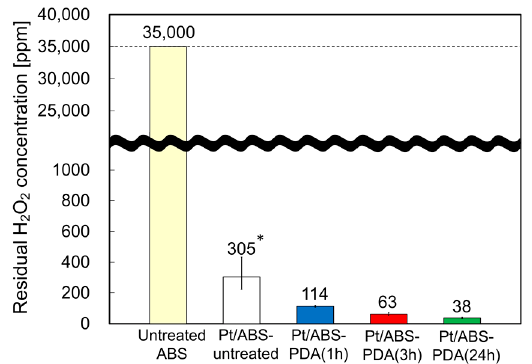
Figure 6. Catalytic activity of Pt/ABS samples with or without PDA coating: residual H 2 O 2 concentration after immersion for 360 min. * The data for the Pt/ABS-untreated are the same as in our previous report [17].